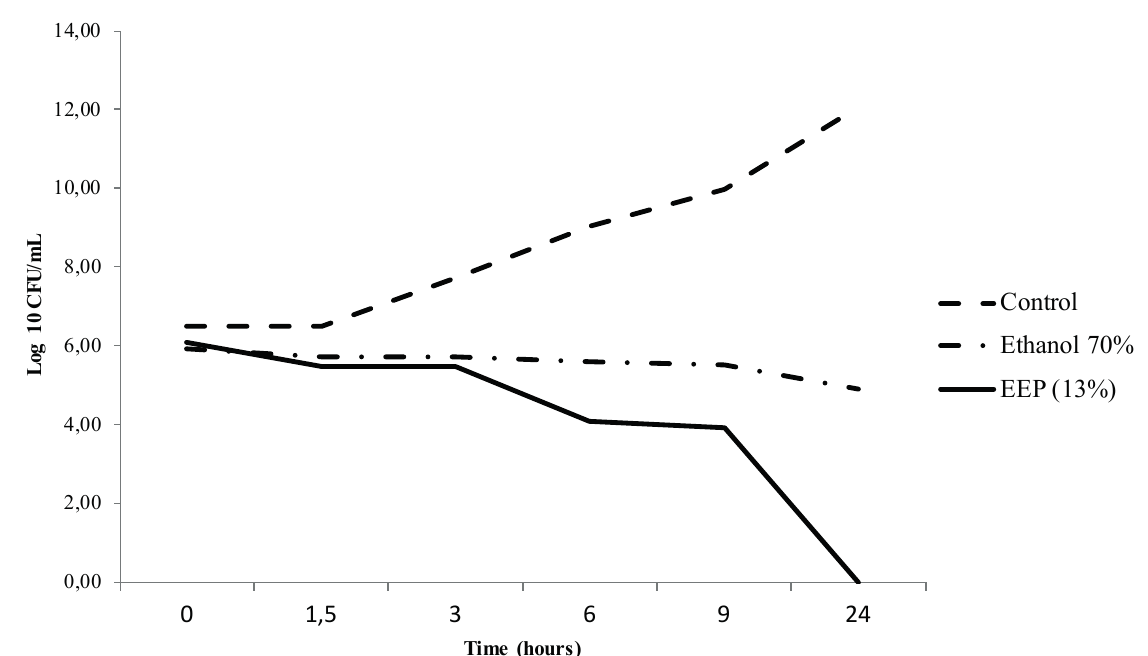
Figure 1 - Susceptibility profile (Log10 UFC/mL) of A. hydrophila as to incubation period in media culture, ethanolic extract of propolis (MIC = 13%) and ethanol 70% (MIC =